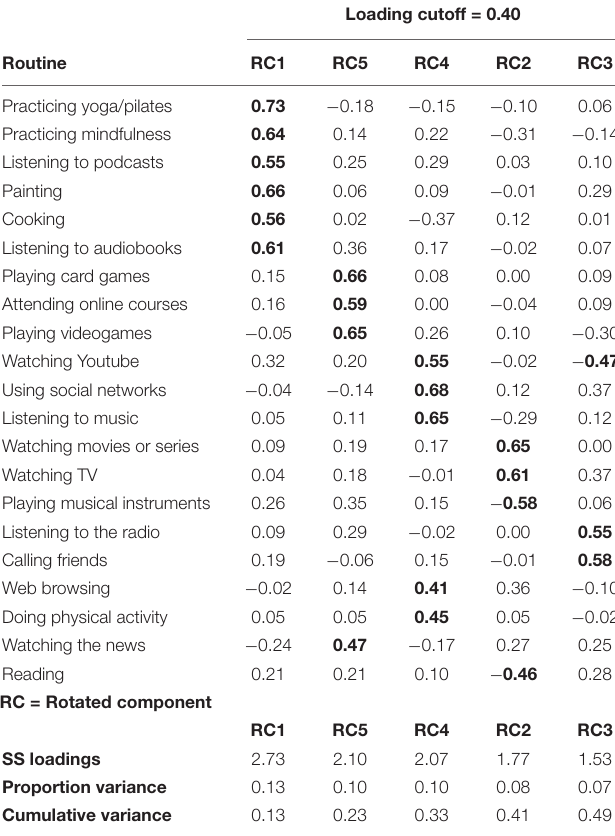
TABLE 2 | PCA loadings for daily routines.